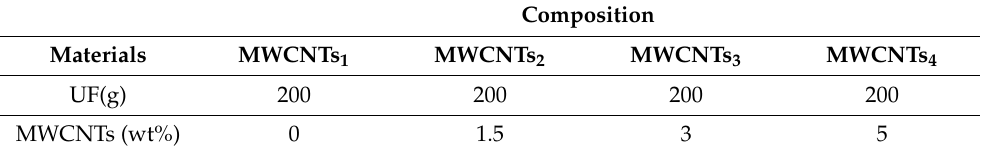
Table 2. Configurations of multiwall carbon nanotubes (MWCNTs)-urea formaldehyde (UF)